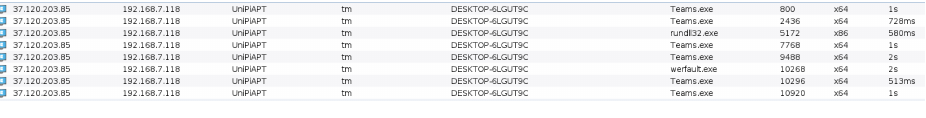
Figure 24. HTA attack against Apex One.